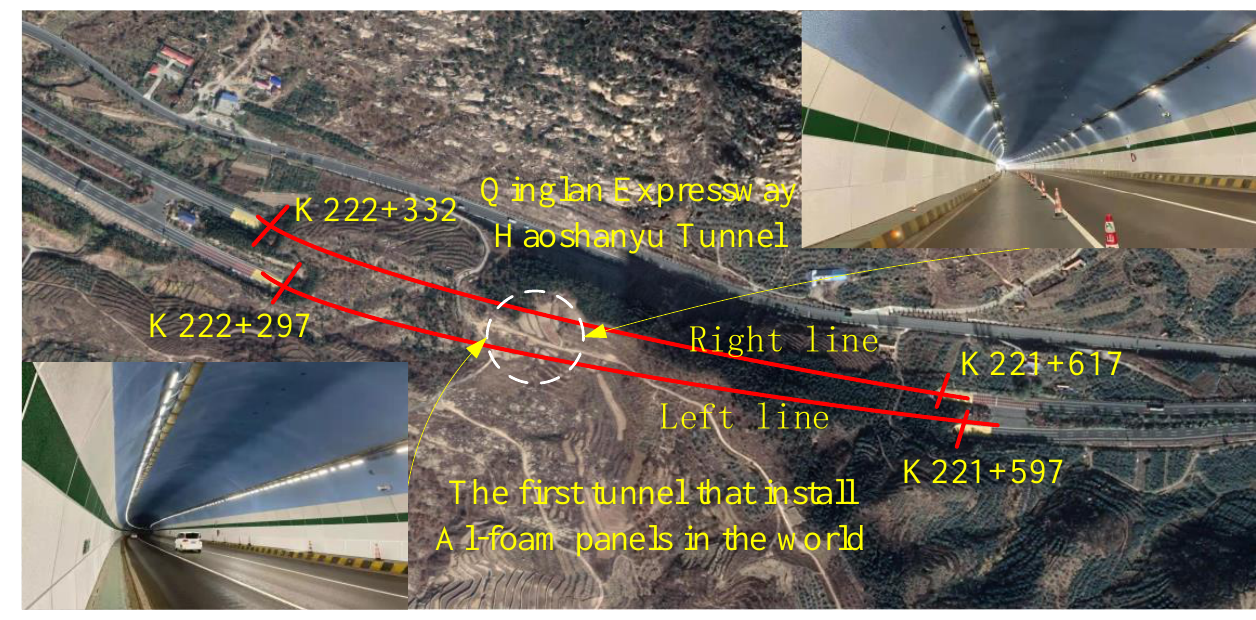
Figure 1. Spatial position of tunnel.